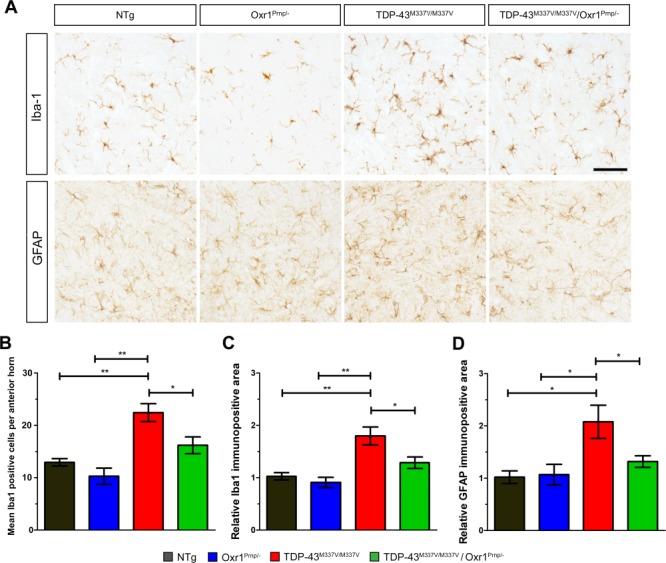
Neuroinflammation in lumbar spinal cords from male TDP-43M337V/M337V mice is alleviated by Oxr1 over-expression. (A) Representative images of spinal cord sections stained with anti-Iba1 and anti-GFAP from male NTg, Oxr1Prnp/−, TDP-43M337V/M337V and TDP-43M337V/M337V/Oxr1Prnp/− mice. (B and C) Quantification of the number of immunopositive cells and immunopositive area for anti-Iba1 reveals increased microgliosis in TDP-43M337V/M337V mice that is significantly reduced in TDP-43M337V/M337V/Oxr1Prnp/− animals. (D) Quantification of the immunopositive area for anti-GFAP signal reveals increased astrogliosis in TDP-43M337V/M337V mice that is significantly reduced in TDP-43M337V/M337V/Oxr1Prnp/− animals. (B–D) Values are shown as the mean ± SEM. N = 3–5 animals per genotype; *P < 0.05, **P < 0.01; One-way ANOVA with Dunnett’s multiple comparison test comparing each group to TDP-43M337V/M337V mice. Scale bar: 100 μm.